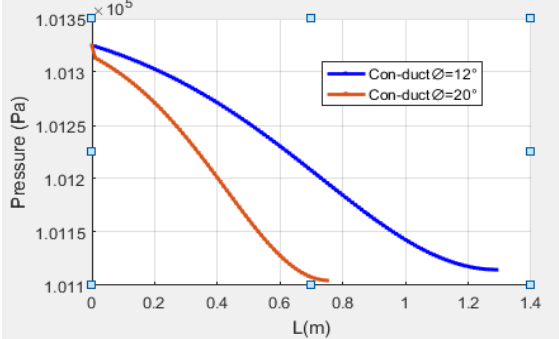
Fig. 10. Pressure distribution along convergent duct inlet angle 20 . °